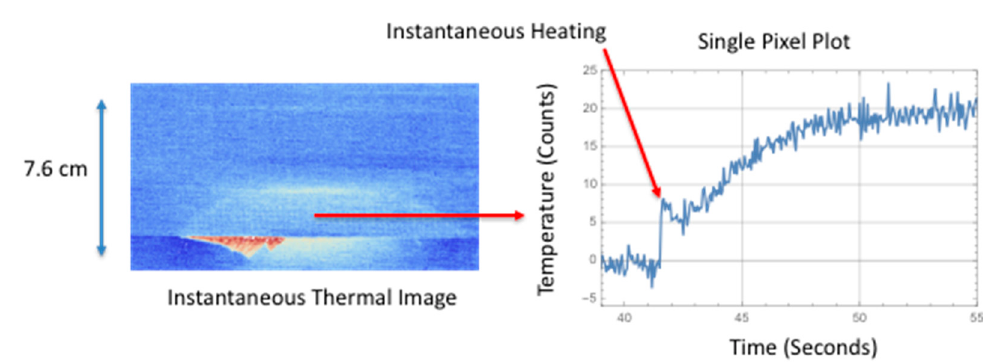
Figure 11. Single pixel plot of instantaneous surface heating for large area failure.